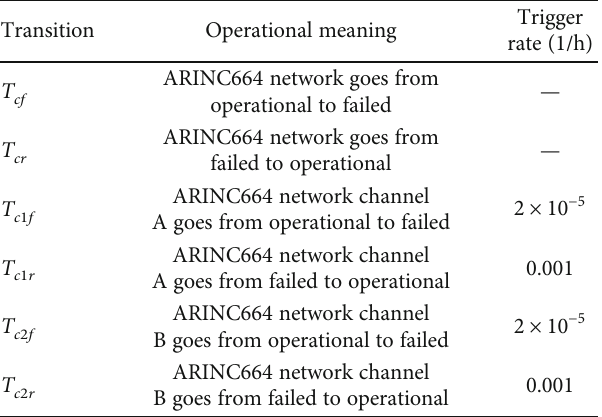
Table 4: Transitions in GSPN model for ARINC664